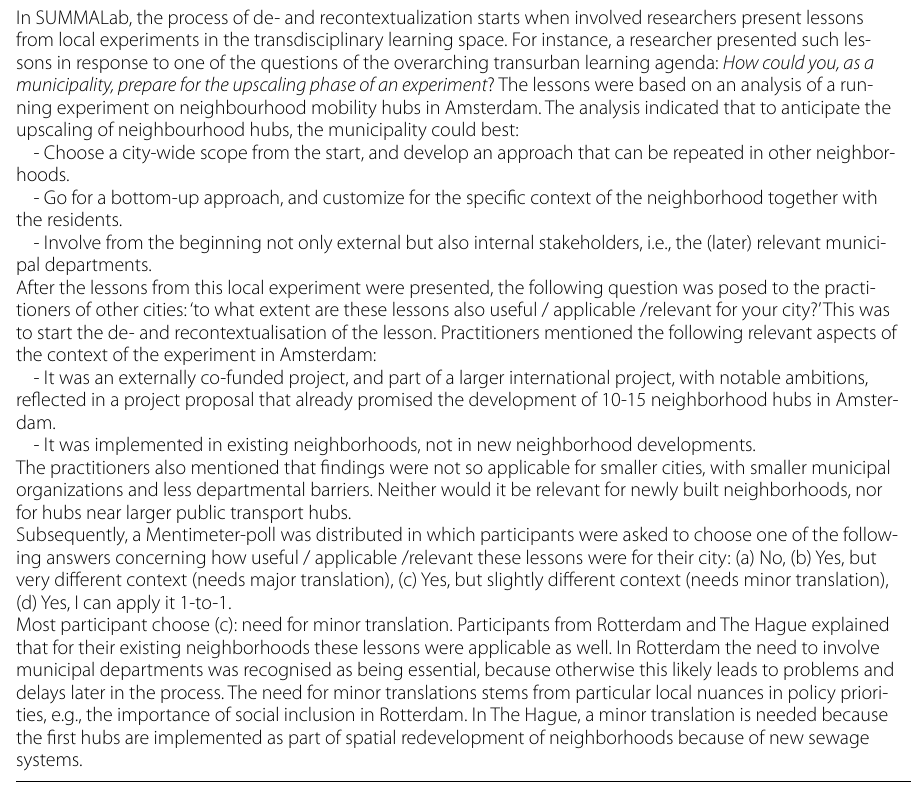
Table 1 An example of decontextualization and recontextualisation In SUMMALab, the process of de- and recontextualization starts when involved researchers present lessons from local experiments in the transdisciplinary learning space. For instance, a researcher presented such les- sons in response to one of the questions of the overarching transurban learning agenda: How could you, as a municipality, prepare for the upscaling phase of an experiment ? The lessons were based on an analysis of a run- ning experiment on neighbourhood mobility hubs in Amsterdam. The analysis indicated that to anticipate the upscaling of neighbourhood hubs, the municipality could